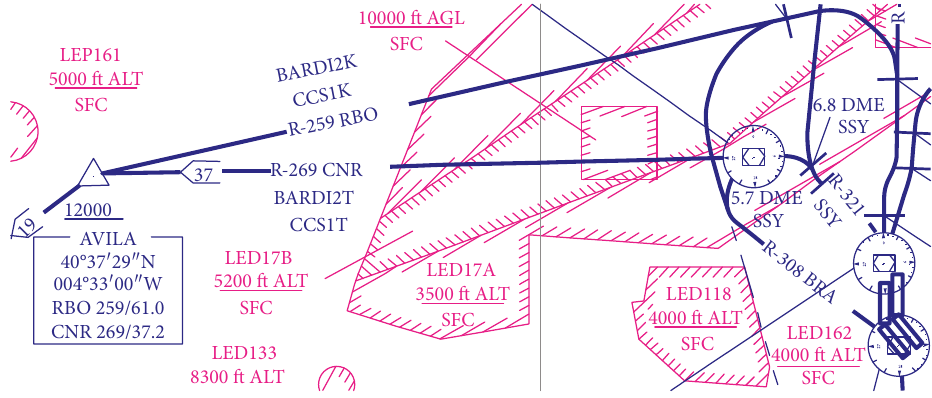
Figure 1: SIDs RWY 36L. Detailed view of selected fl ight segments associated to BARDI2T/CCS1T & BARDI2K/CCS1K SIDs. Table 1: Operational